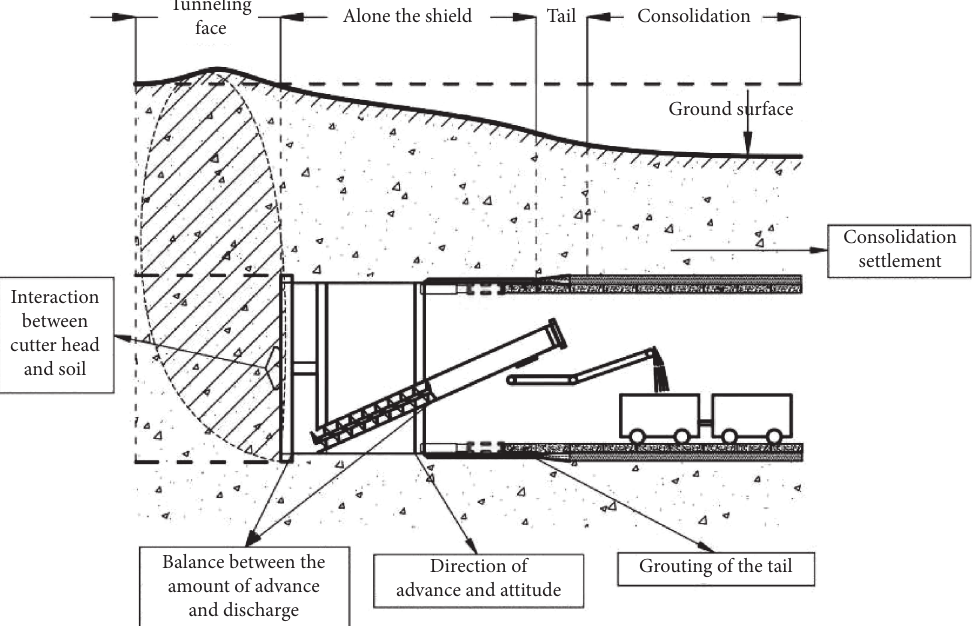
Figure 3: Five main factors affecting the ground loss resulting from EPB shield tunneling.